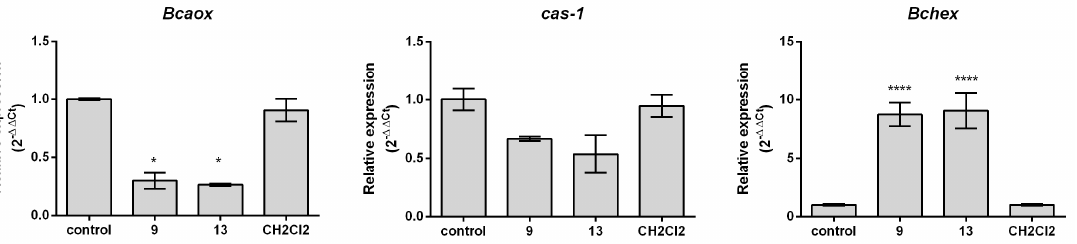
Figure 4. The transcript expression of genes Bcaox , Cas-1 , and Bchex in the spores of B. cinerea after the application of derivatives ( 9 ) and ( 13 ). The relative transcript expressions were analyzed by real-time PCR. The unity value of relative expression corresponds to nontreated samples. All data represent the means of three independent replicates ± SD ( n = 9). The significance of the difference was analyzed by Sidak’s multiple comparison tests (* p < 0.05); asterisks indicate significant differences compared with negative control under the same treatment conditions (**** p < 0.0001).